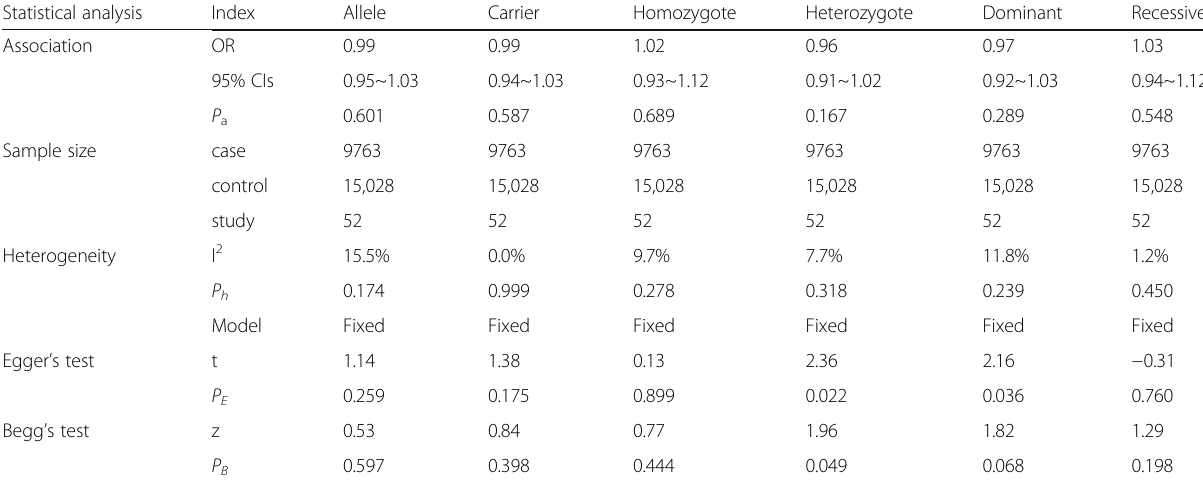
Table 2 Meta-analysis of the GSTP1 rs1695 A/G polymorphism Statistical